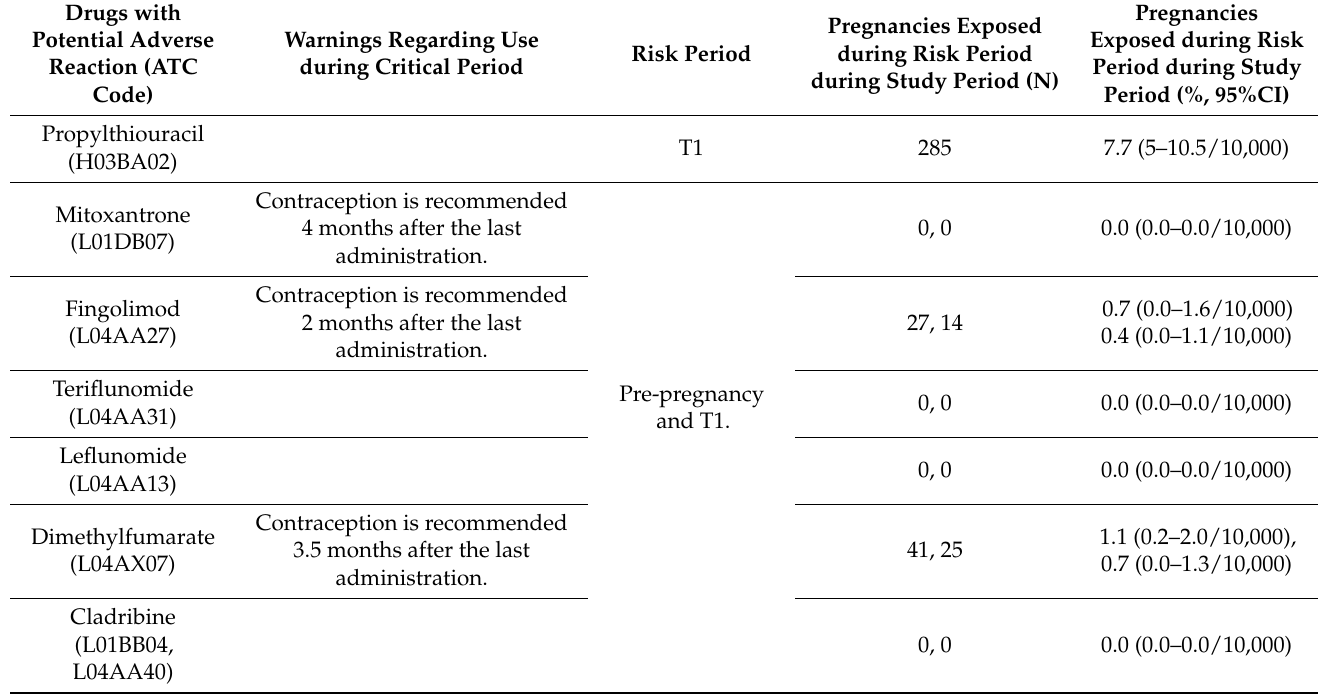
Table 5. Exposure to drugs with potential adverse reaction during trimester 1 (risk found in animal studies but not in human data) during risk period and associated potential risks (weighted